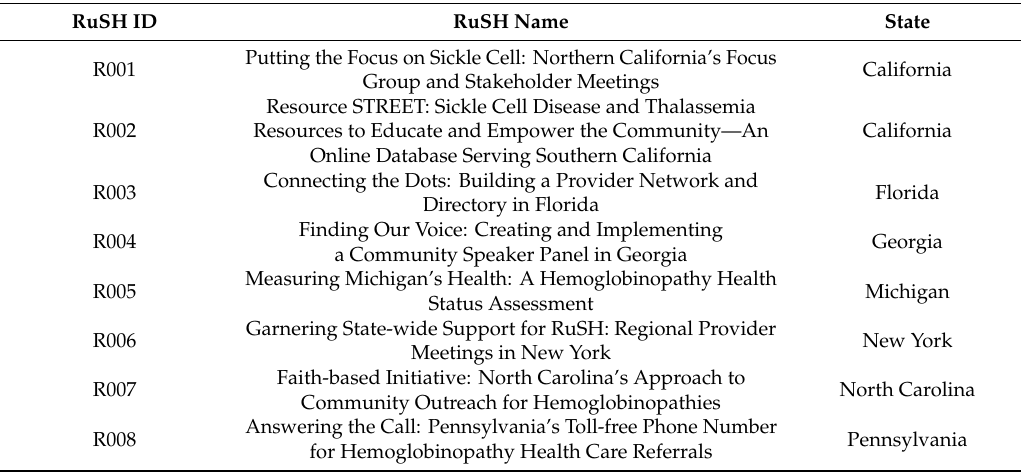
Table 2. Sites for the Registry and Surveillance System for Hemoglobinopathies (RuSH) Report.